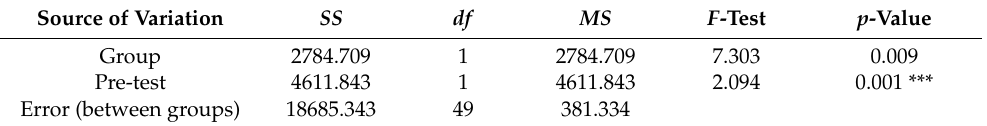
Table 4. Analysis of covariance: learning e ff ectiveness of two